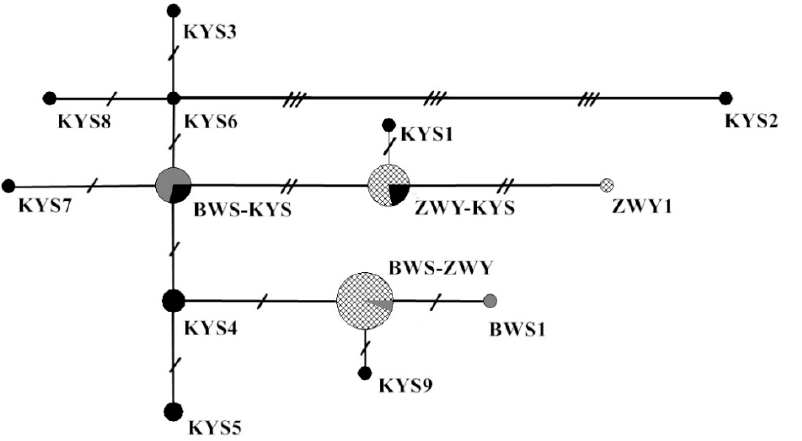
Figure 2. Network diagram based on mtDNA D-loop region haplotypes. The size of circles is related to the frequency of the haplotypes; different patterns in circles represent different populations and short lines represent mutation steps.